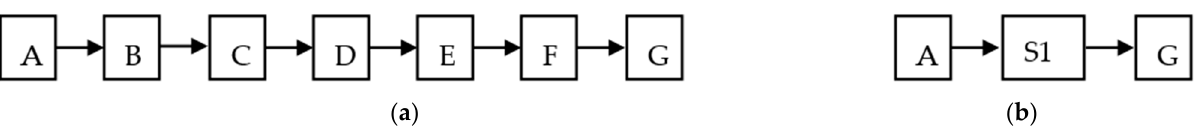
Figure 4. Sequences of activities. ( a ) Includes the original sequence obtained by the algorithm. ( b ) Includes the modified sequence from a visual abstraction of the pattern.